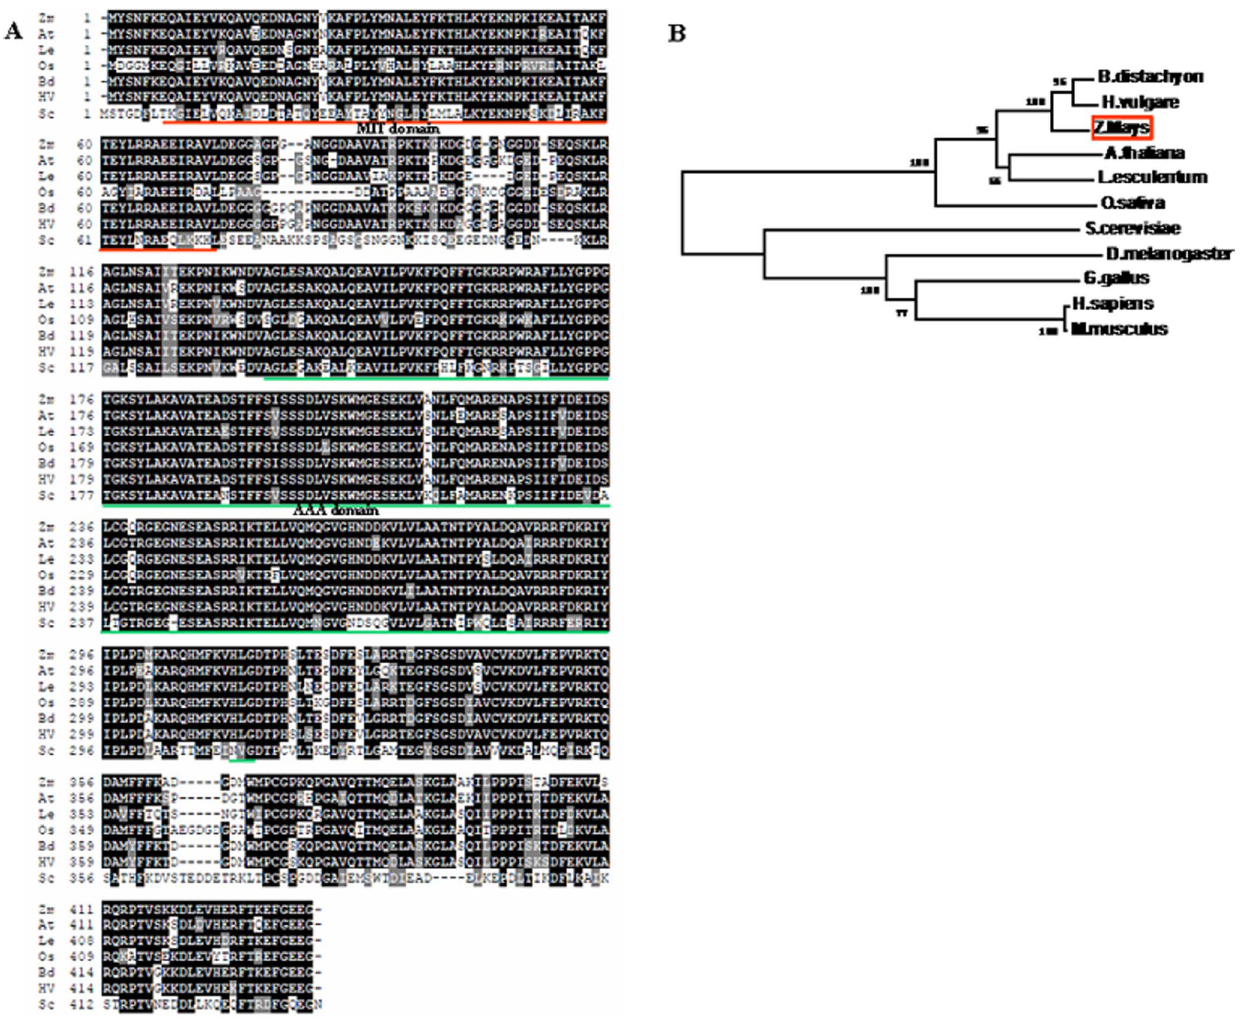
Figure 1. Sequence alignment and phylogenetic analysis of SKD1 proteins from ZeaMays and other species. A An alignment is shown for the deduced amino acid sequence of SKD1s from Zea Mays (Zm), Arabidopsis thaliana (At), Lycopersicon esculentum (Le), Oryza sativa (Os), Brachypodium distachyon (Bd), Hordeum vulgare (Hv) and Saccharomyces cerevisiae (Sc). The numbers on the left indicate the amino acid position. Identical residues in all these proteins are shown in a black background. Dashes indicated gaps introduced for optimal alignment. The putative MIT and AAA domains are underlined with a thick red line and a thick green line, respectively. B Phylogenetic tree based on SKD1 protein sequences from yeast, plants, and animals. The bootstrap values shown were calculated based on 500 replications. The tree was constructed using the neighbor- joining method. Z.mays , AY105155; A.thaliana , At2g27600; L.esculentum , AK324437; O.sativa , AF499028; B.distachyon , LOC100837561; H.vulgare , AK359160; D.melanogaster , NP_573258; G.gallus , AJ720732; H.sapiens, AF038960; M.musculus , NP_033216; S.cerevisiae ,